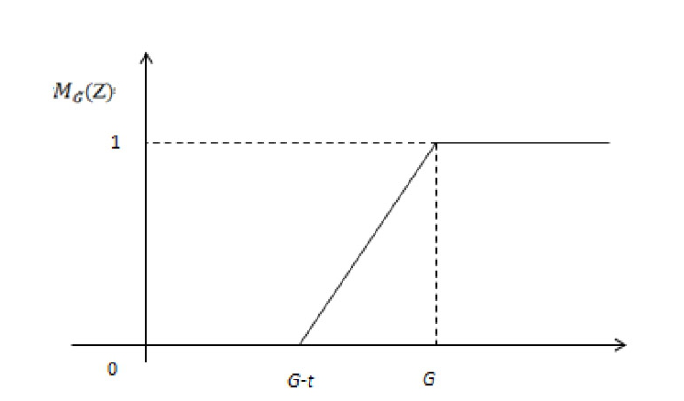
Figure 6. Variation of the food allocation performed by the model for each α